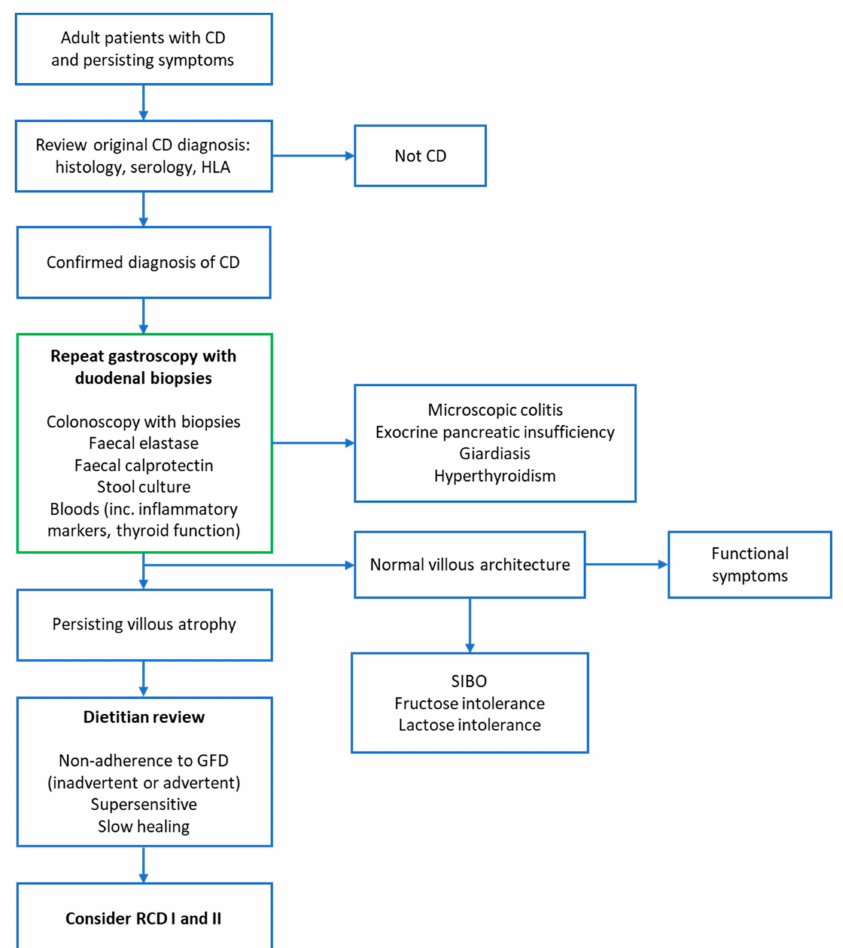
Figure 1. Algorithm for investigating coeliac patients with persisting symptoms. Investigations outlined in the green box can be planned for during the initial follow-up appointment in suspected non-responsive coeliac disease (NRCD). This may expedite the identification and diagnosis of RCD. Where there is clear clinical concern of ongoing gluten ingestion, a dietary review earlier in the investigation pathway may prevent unnecessary tests for some patients. However, we would always advocate repeat duodenal biopsies in individuals presenting with NRCD. Modified with permission from